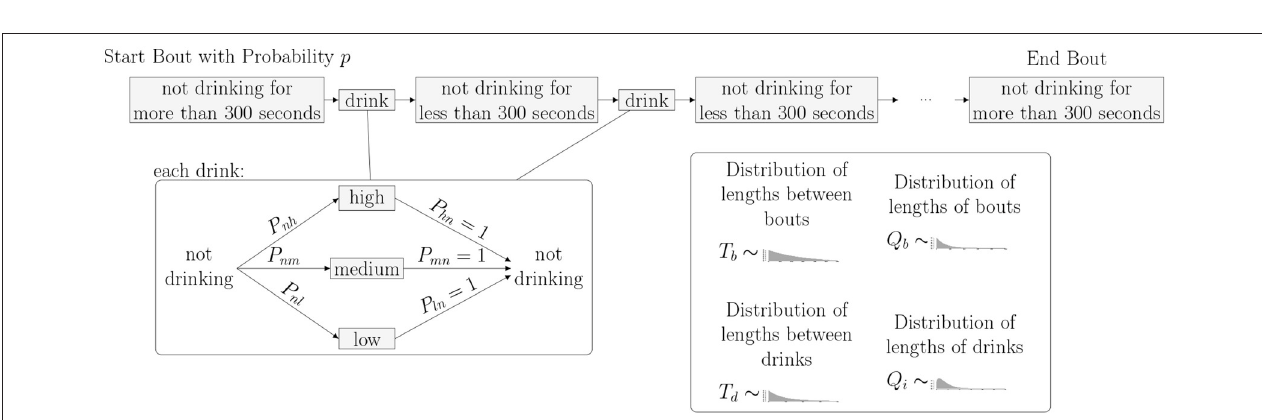
FIGURE 2 | Bouts and Drinks: The length of time between drinks determines if a monkey is in a bout or not. When not in a bout, a monkey takes an individual drink. When in a bout, a monkey takes several drinks in a row with short times in between. Regardless of whether or not the monkey is in a bout, a Markov Process dictates the level of each drink where state 1 is not drinking, state 2 is low, state 3 is medium, and state 4 is high.